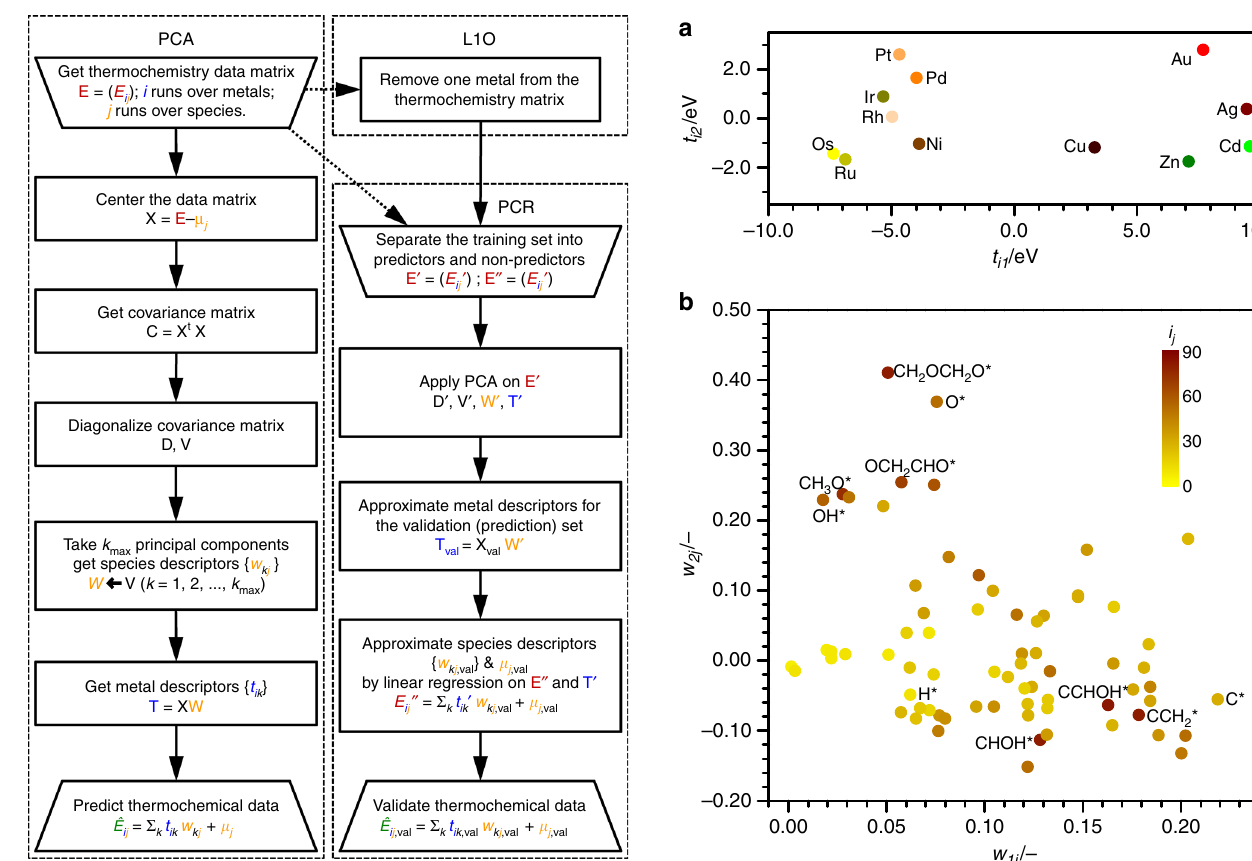
Fig. 2 Descriptors from principal component analysis. Descriptors for a metals fð t i 1 ; t i 2 Þg and b adsorbates fð w 1 j ; w 2 j Þg , obtained by PCA. The color scale in b measures the robustness of each species of being a predictor ( ι j